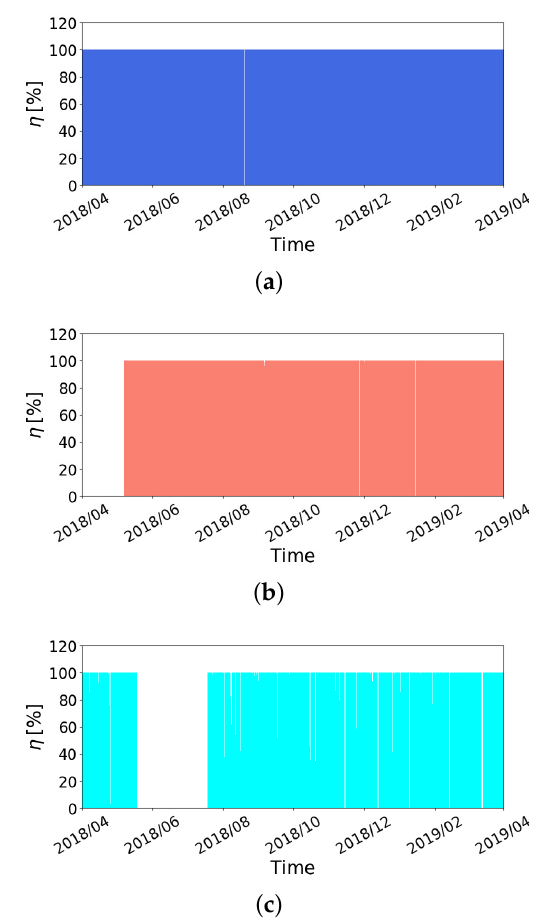
Figure 4. Data availability for the period of one year from April 2018 through March 2019. ( a ) Cup anemometer; ( b ) Sonic anemometer; ( c ) V2 profiling